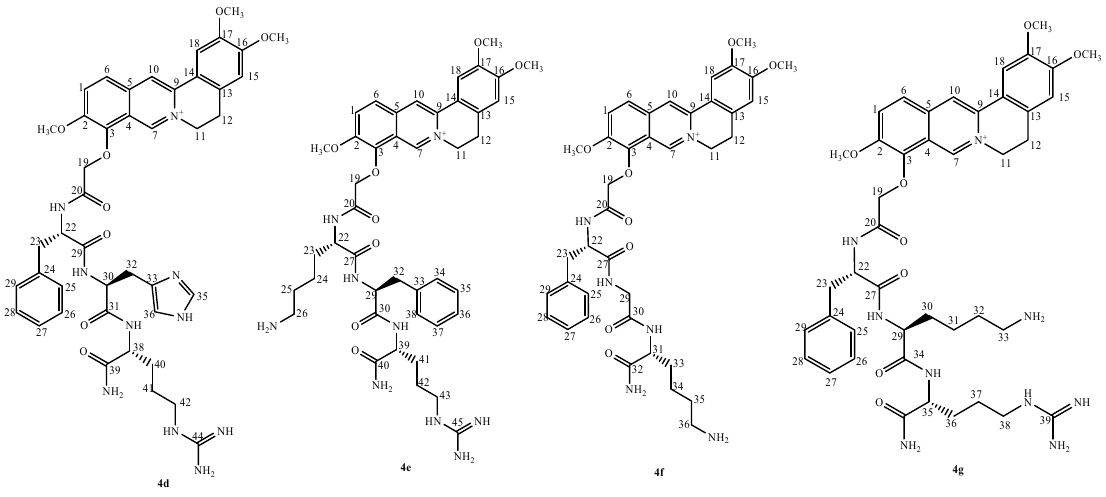
Figure 5. Structures of compounds ( 4d – 4g ).